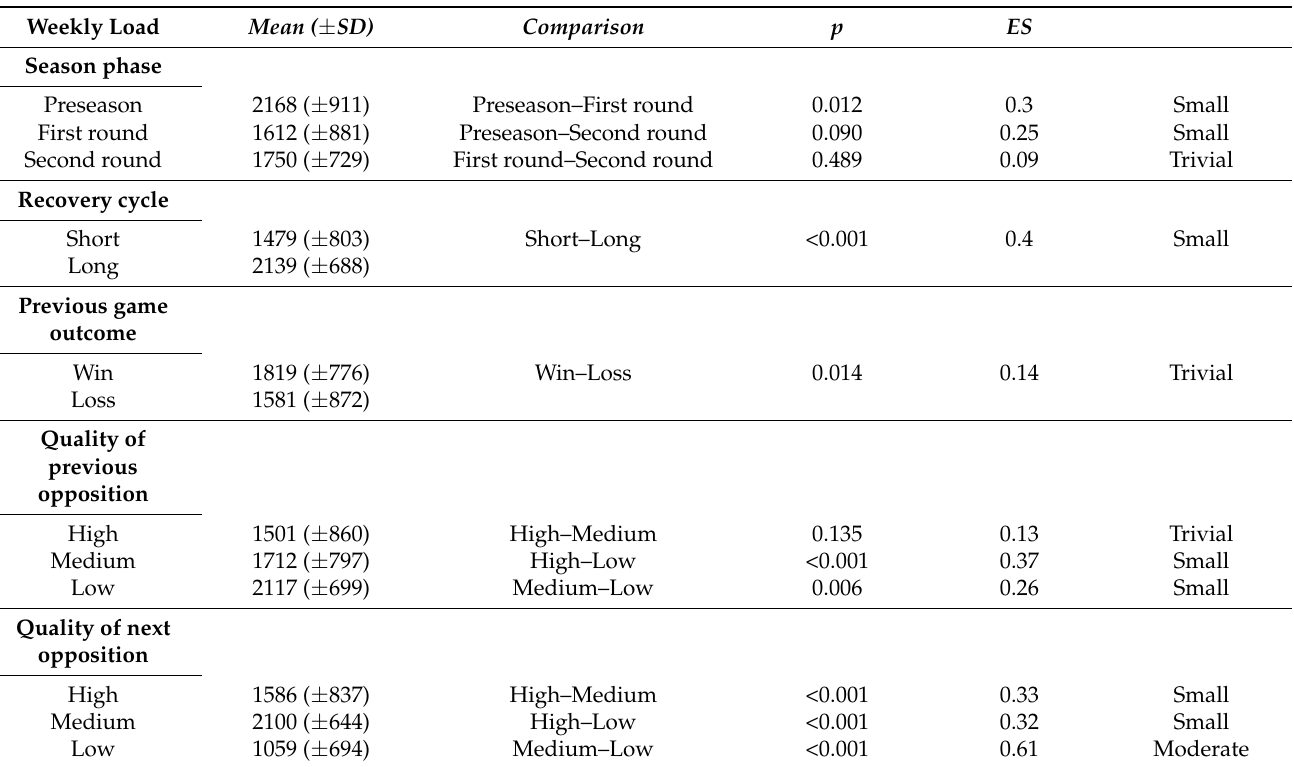
Table 6. Pairwise comparison for weekly